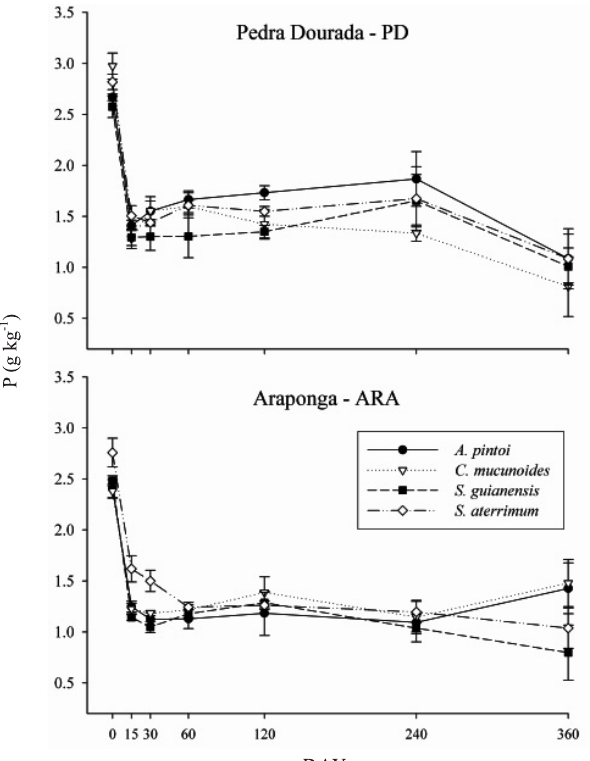
Figure 5. Phosphorus concentration of different leguminous plants, in 360 days in Pedra Dourada and Araponga. Vertical bars represent standard error (n =